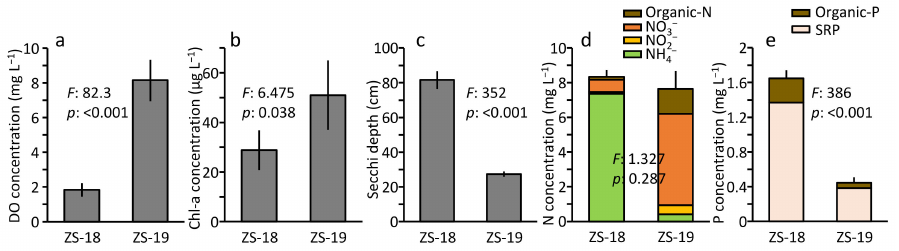
Figure 2. Comparisons of DO ( a ), Chl-a ( b ), transparency ( c ), and N ( d ) and P ( e ) concentrations between ZS-18 (before installation) and ZS-19 (after installation). Error bars are standard deviation ( n : 4–6). Organic portion of nutrients were calculated from the difference between total and other forms. Results of ANOVA are also